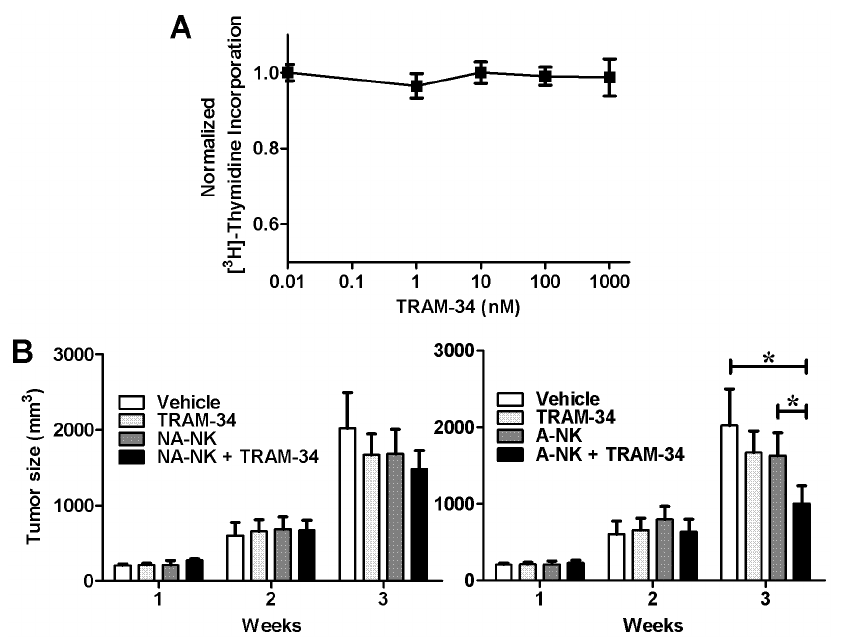
Figure 9. TRAM-34 promotes A-NK cell antitumor activity invivo . A: Lack of effects of TRAM-34 on [ 3 H] thymidine incorporation by K562 cells. N=4 independent experiments. B: Effect of NA-NK ( left ) and NA-NK ( right ) cells on the size of K562 tumors in the absence (dark grey) and presence (black) of 120 mg/kg TRAM-34. Vehicle control in shown in white and TRAM-34 in the absence of NK cells in light grey. Data represent the mean 6 SD tumor size for each group (n=5 mice/group) at each time point. *p , 0.05.